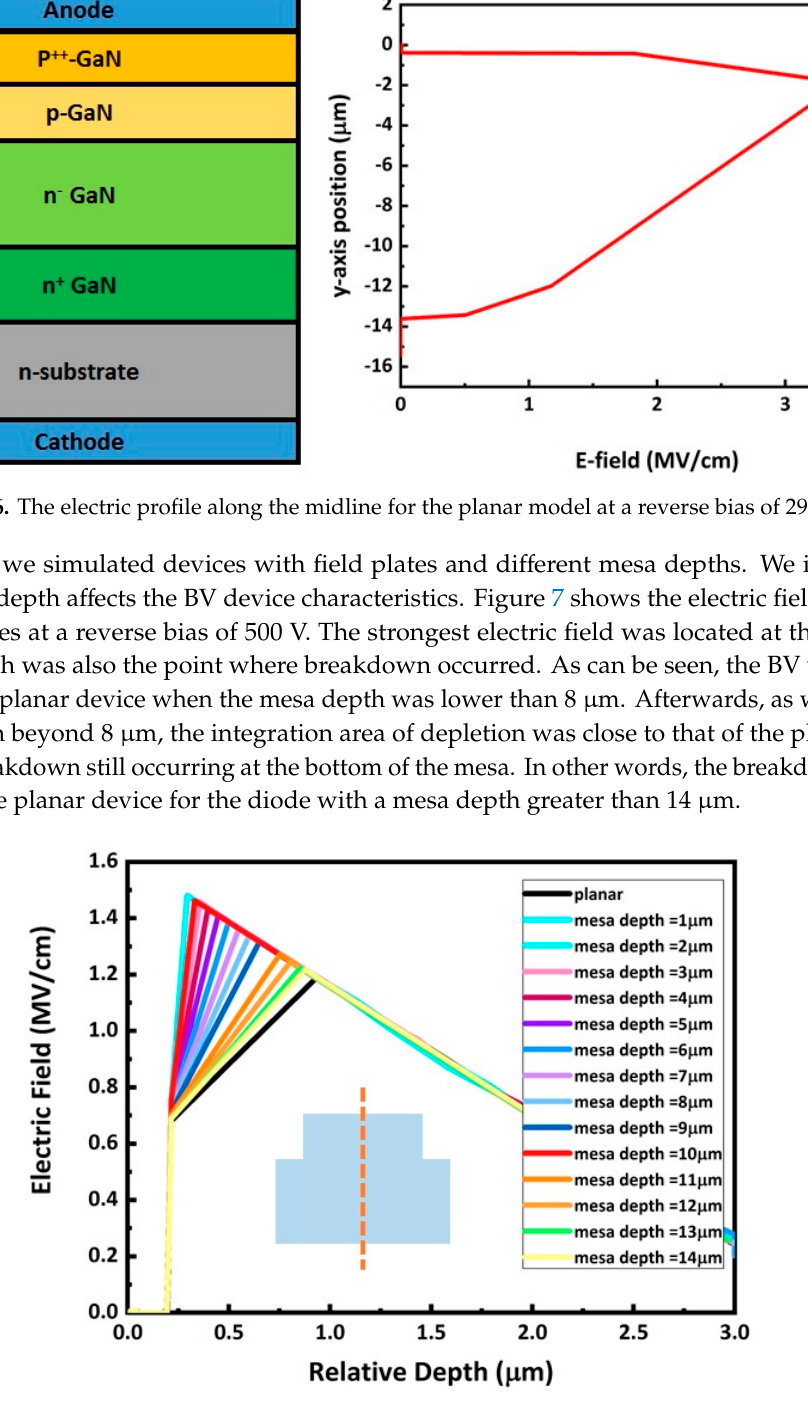
Figure 7. The electric field profile along the mesa midline for different devices at a reverse bias of 500 V.